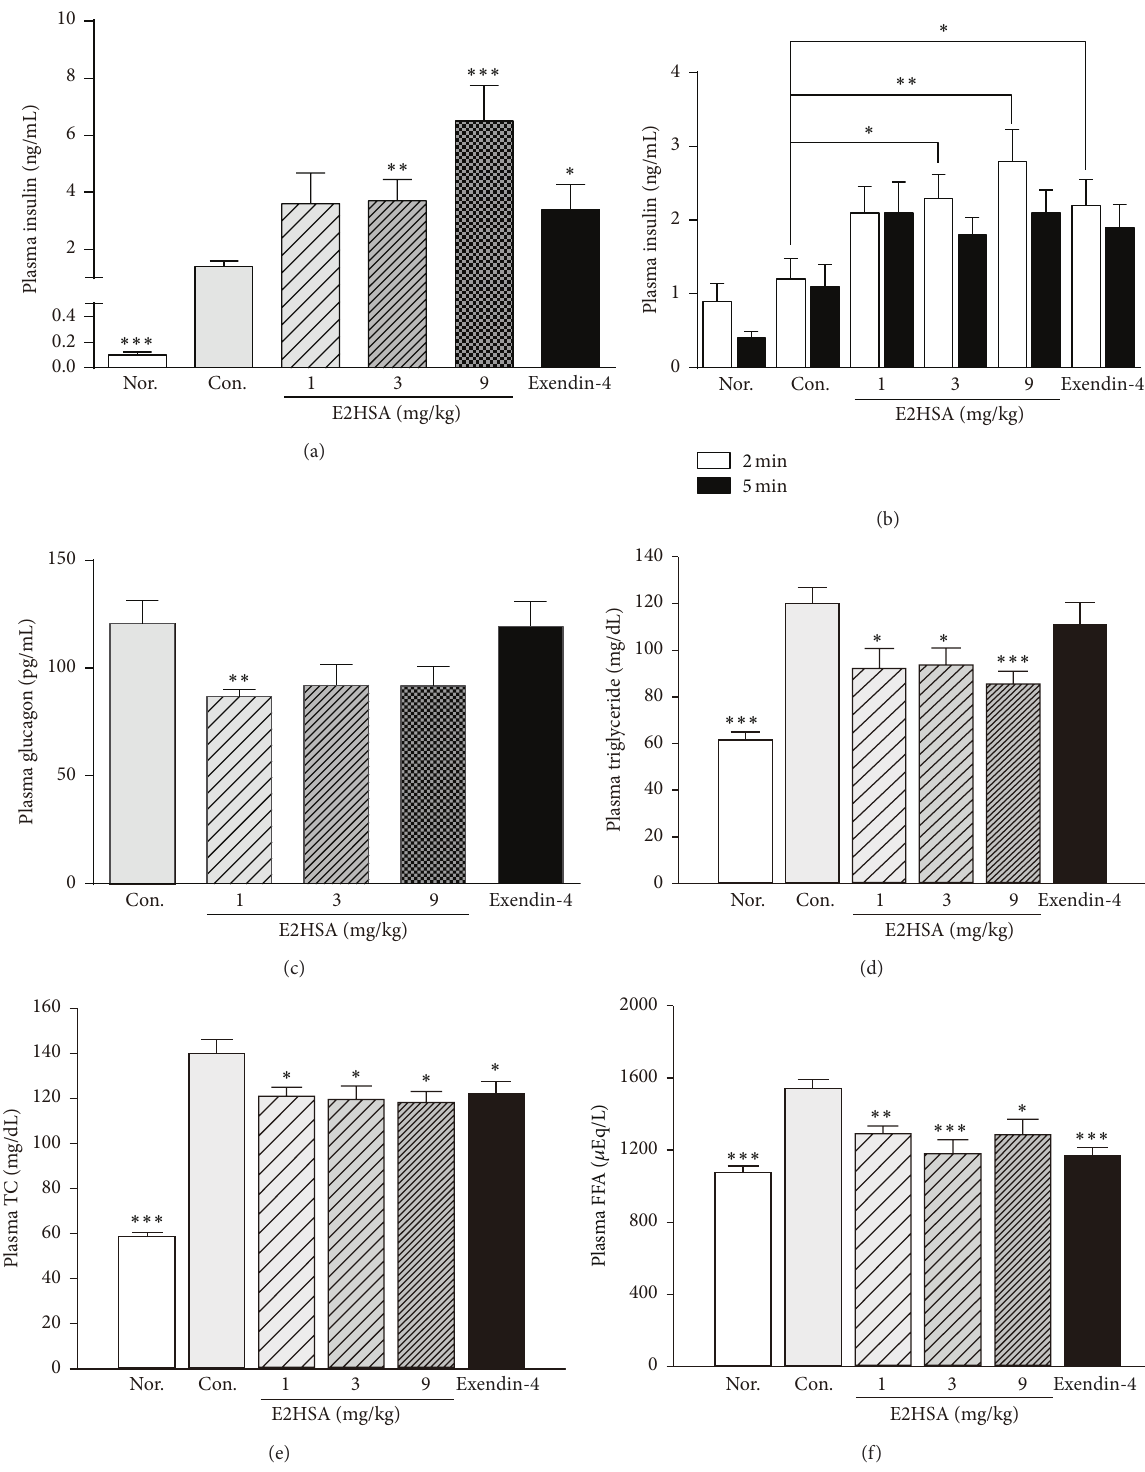
Figure 5: Effects of E2HSA on islet hormone secretion and plasma lipid levels in spontaneous type 2 diabetes db/db mice. (a) Fasting plasma insulin levels at the 2nd week. (b) Plasma insulin levels at 2 minutes and 5 minutes after intravenous glucose challenge in IVGTT. (c) Fasting plasma glucagon levels at the end of the experiment. ((d)–(f)) Fasting plasma triglyceride levels from the 5th week (d), fasting total plasma cholesterol levels from the 1st week (e), and fasting plasma FFA levels from the 2nd week (f) were represented here. Nor., db/m mice administered normal saline. Con., db/db mice administered normal saline. Data are expressed as mean ± S.E.M ( 𝑛 = 10 - 11 ). ∗ 𝑃 < 0.05 , ∗∗ 𝑃 < 0.01 , and ∗∗∗ 𝑃 < 0.001 versus